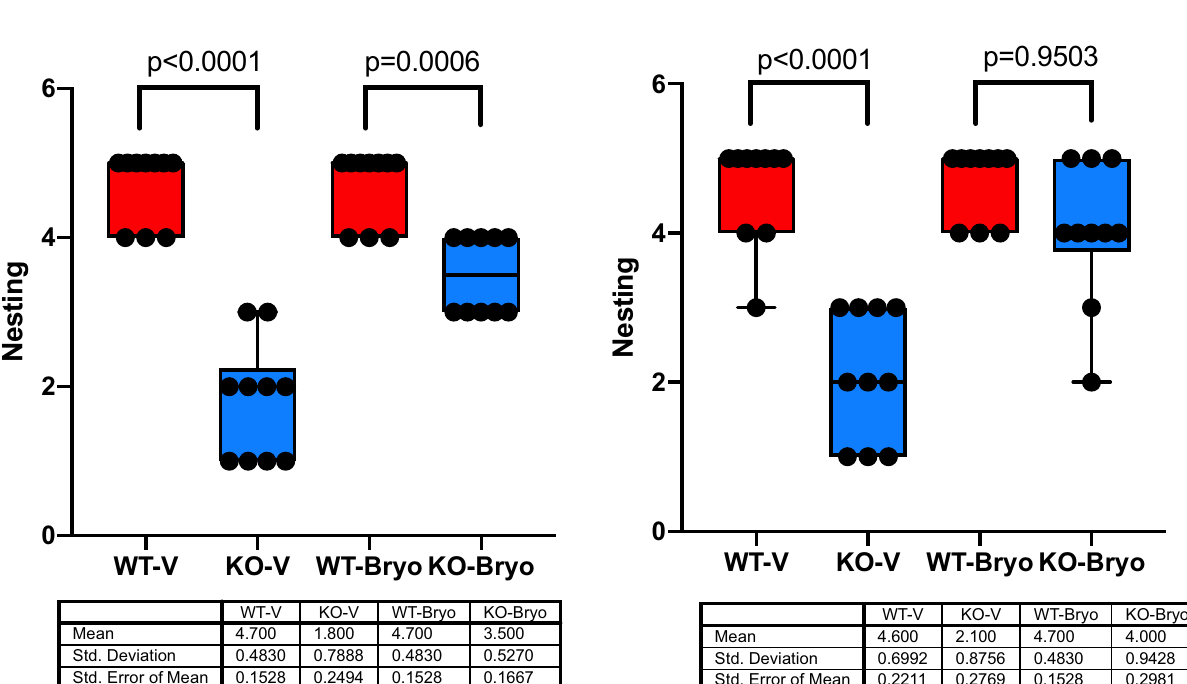
Figure 2. Chronic bryostatin-1 rescues impaired nesting activity of the Fmr1 KO2 mice. Wild-type (WT) or Fmr1 KO2 (KO) adult mice were treated with vehicle (V) or bryostatin-1 (Bryo) for 5 weeks (Study 1) or 13 weeks (Study 2) and then tested in nesting activity. Chronic treatment with bryostatin 1 for 13 week improves Fmr1 KO2 nesting behavior to wild-type levels ( P = 0.9503). Data is visualized as boxplots with interquartile ranges, presenting all the data points. The table indicates the mean standard deviation and the standard error of the mean (N = 10 mice per